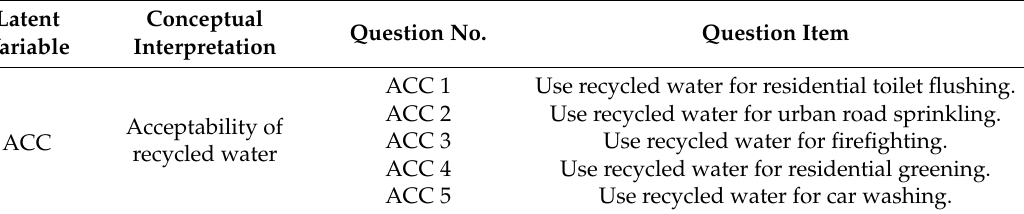
Table 3. Measurement table for ACC.